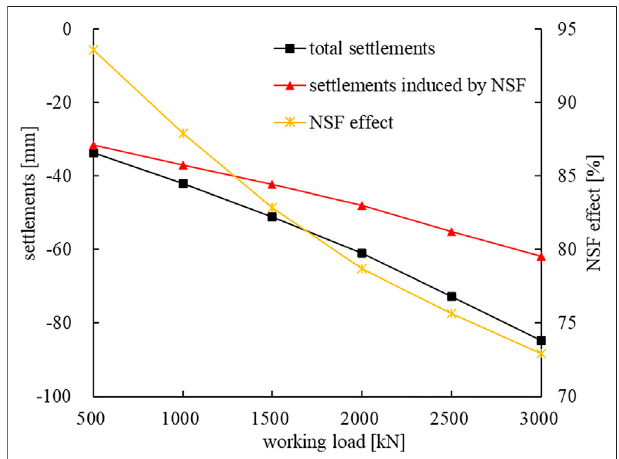
FIGURE12| DevelopmentofthesettlementsandtheNSFeffectwithan increase of the working load.